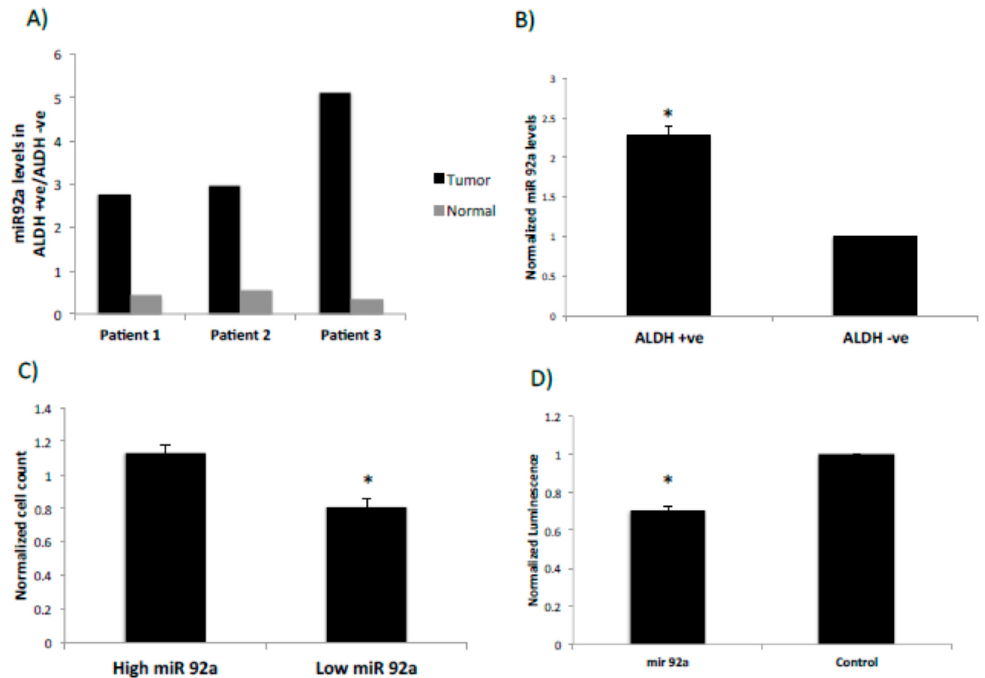
Figure 3. MicroRNA92a is overexpressed in ALDEFLUOR positive cells and regulates the LRIG1 gene expression. ( A ) MicroRNA92a expression in tumor and normal ALDEFLUOR positive cells compared to ALDEFLUOR negative cells in patient samples. The results show miRNA92a expression is upregulated in ALDH ‐ positive SCs from CRCs compared to ALDH ‐ positive SCs from normal colonic epithelium. ( B ) Normalized miRNA92a expression levels in sorted ALDEFLUOR positive and negative HT29 cells. The results show miRNA92a expression is upregulated in ALDH ‐ positive cells compared to ALDH ‐ negative cells from the HT29 CRC line. ( C ) Normalized fold change in cell count of HT29 cells with increased and decreased levels of miRNA92a . The results show transfecting HT29 cells with miRNA92a antimir significantly reduces cell numbers and miRNA92a precursor has the opposite effect. ( D ) Luciferase assay shows that miRNA92a targets 3 ′ UTR of LRIG1 gene indicated by the significant decrease in the relative luminescence intensity as compared to the control. The results indicate miRNA92a down ‐ modulates LRIG expression. Error bars represent standard error of mean and * represents a significant p value < 0.05.